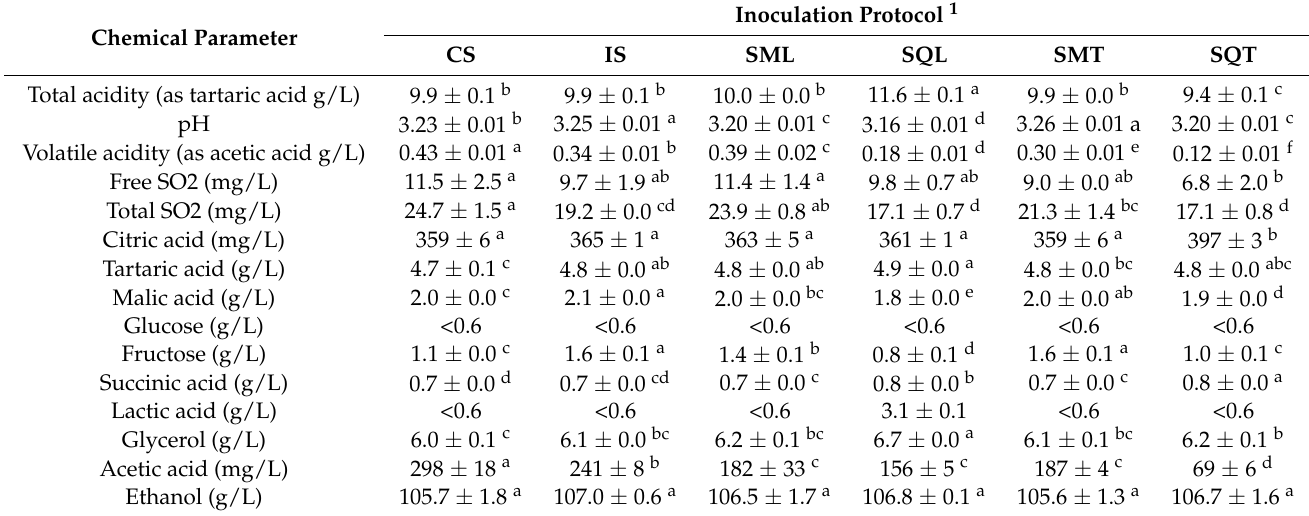
Table 1. Chemical parameters of ferments produced in laboratory-scale fermentations of sterile must (mean ± SD, n = 3). Different letters indicate significantly different values ( p < 0.05).